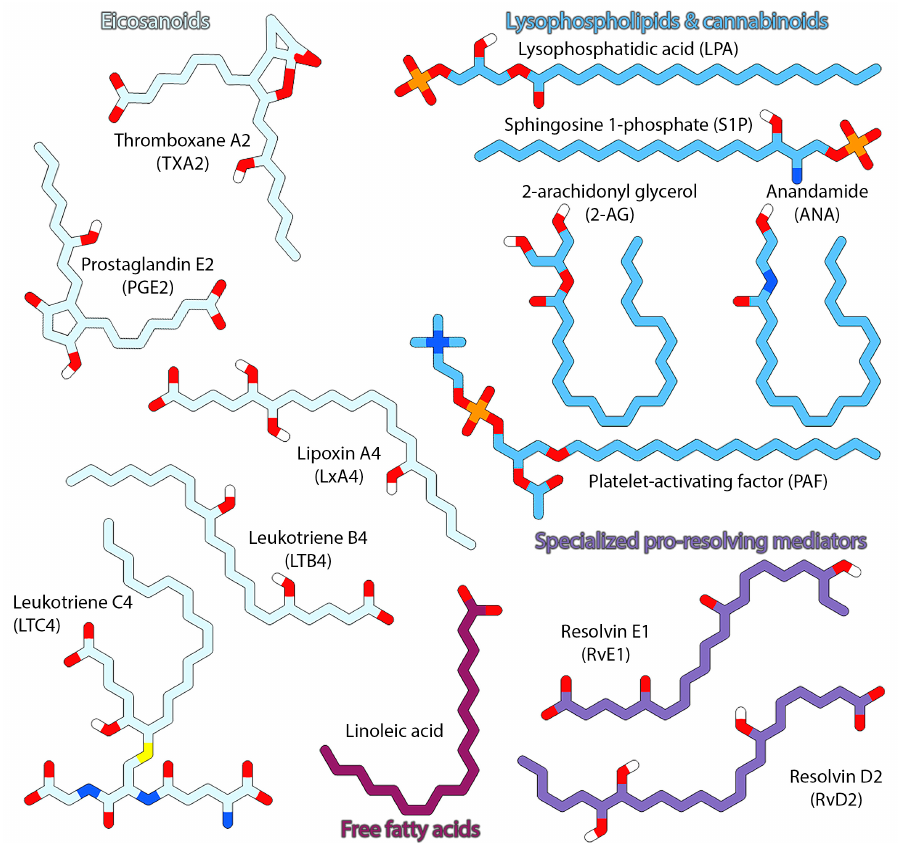
Figure 1. Two-dimensional structures of a few representative examples of endogenous lipid mediators (LMs), belonging to the different classes involved in diverse signaling pathways.